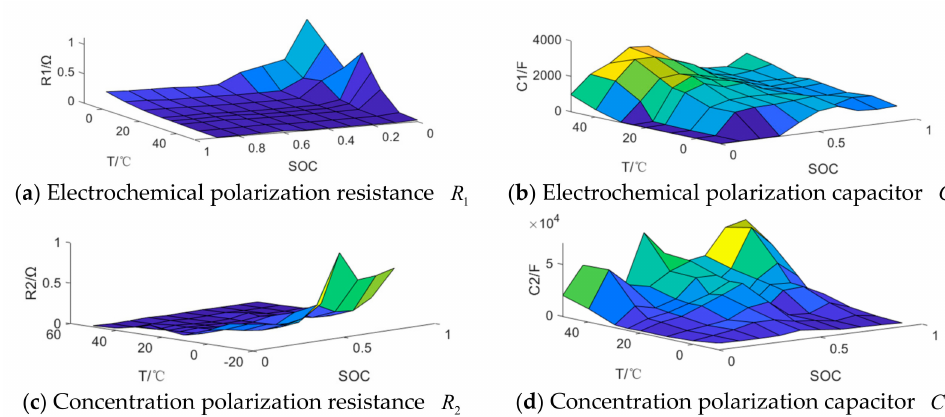
Figure 8. Polarization parameters at different temperatures and SOC